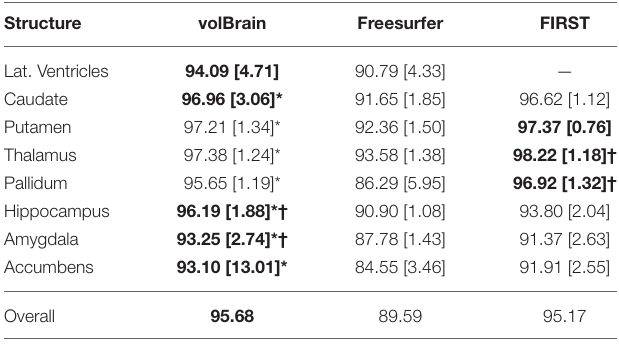
TABLE 3 | Median of